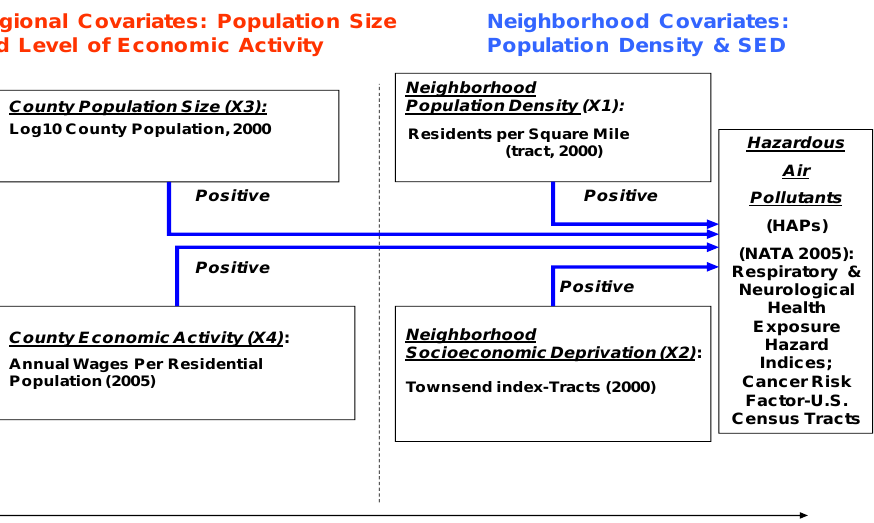
Figure 1. Multilevel Urban Market Exposure Model for HAPs: Differential Exposure Related to Neighborhood Socioeconomic